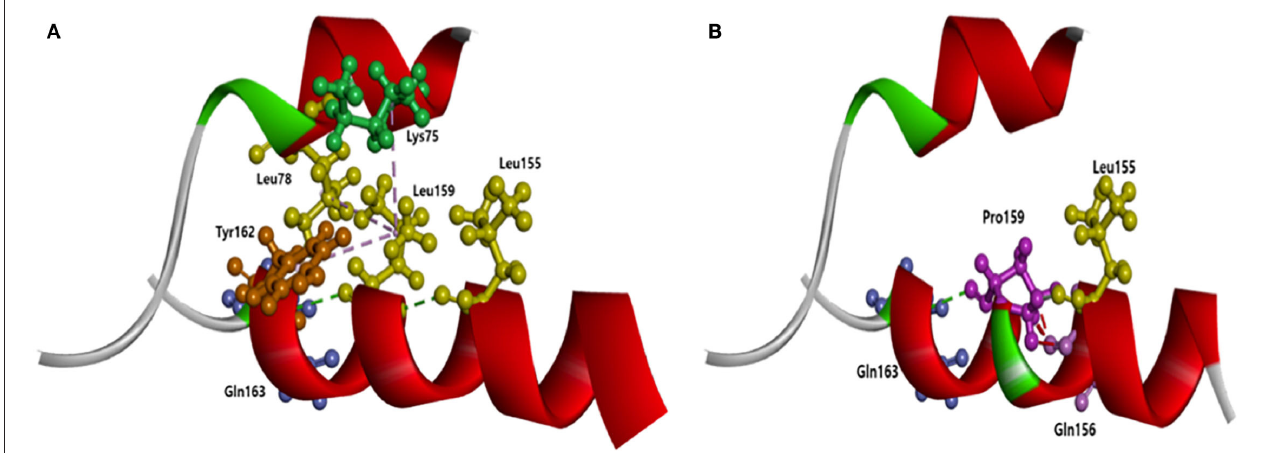
FIGURE 5 | Intramolecular interactions of APOE with Leu159, compared to the APOE with Pro159. Pro159 may significantly disturb the intramolecular structure of APOE by the loss of contact between Helix-1 and Helix-4. (A) Normal APOE with Leu159; (B) Mutant APOE with Pro159.